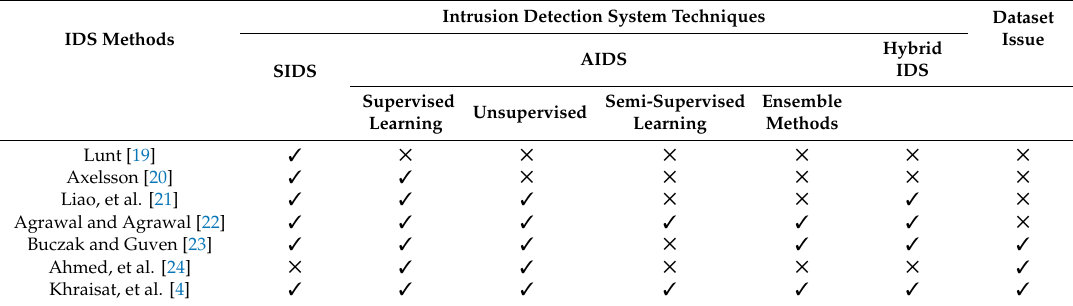
Table 1. Comparison of intrusion detection systems (IDS) techniques and datasets issue covered ( (cid:51) : Topic is covered, (cid:53) the topic is not